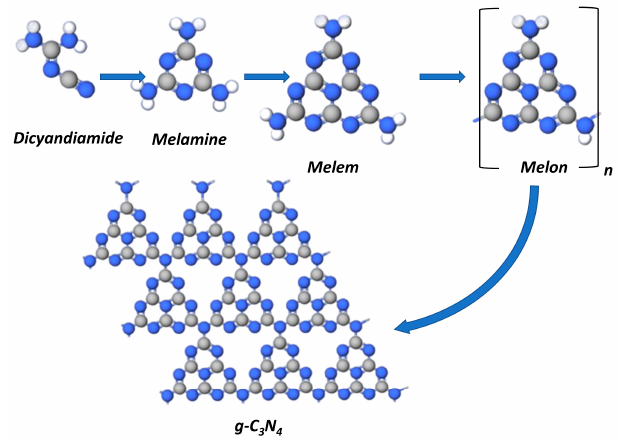
Figure 2. Thermal condensation of dicyandiamide to form g-C 3 N 4 .